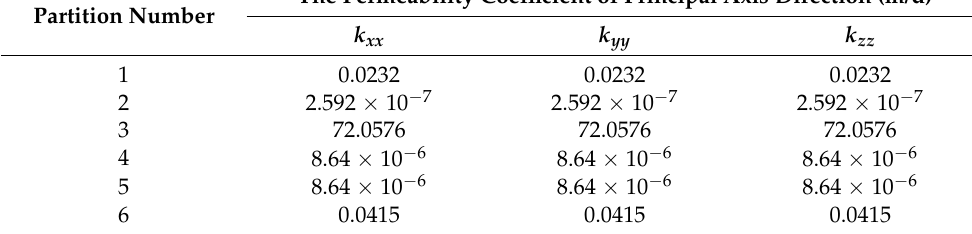
Table 2. Permeability coefficient of each layer.